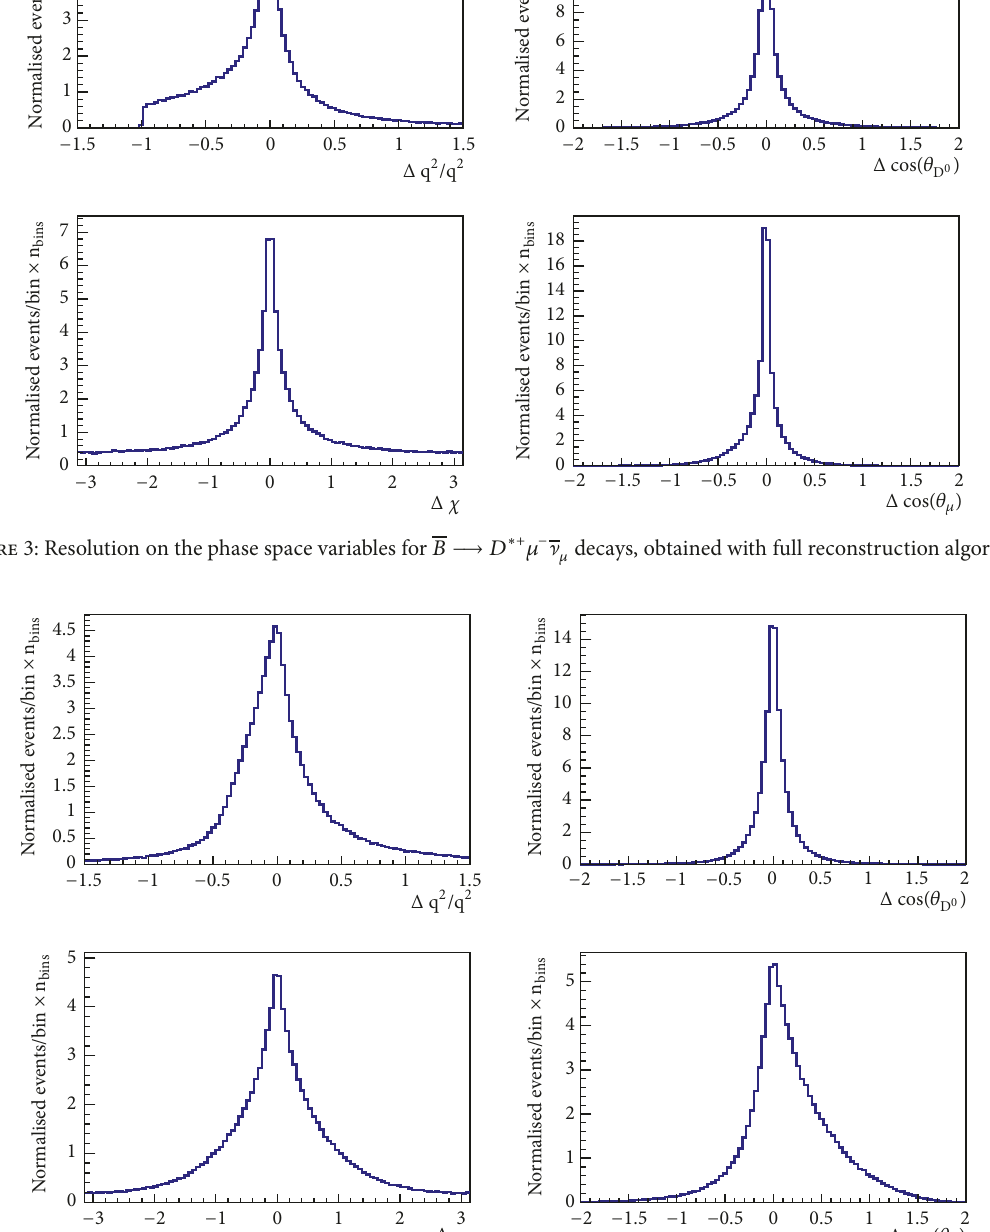
depend on the leptonic part of the decay. The 𝜒 distributions are however still unbiased, while the cos 𝜃 𝑙 ones are asym- metric and biased, especially for the equal velocity